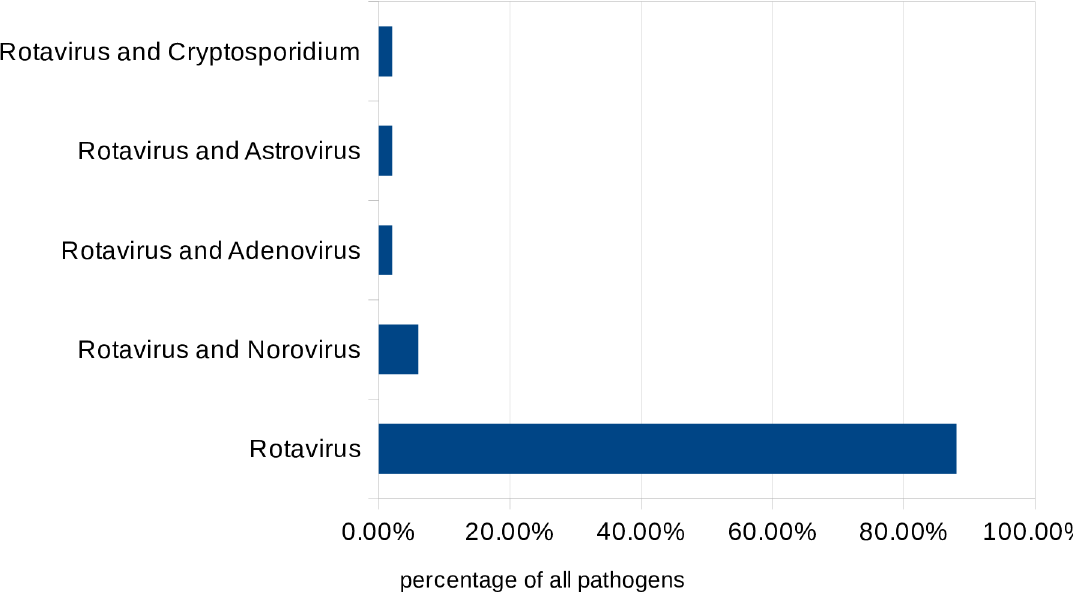
Fig 2. Diarrhoea pathogens identified in the stool sample in addition to rotavirus / Concomitant or secondary GI infection (RPG group).